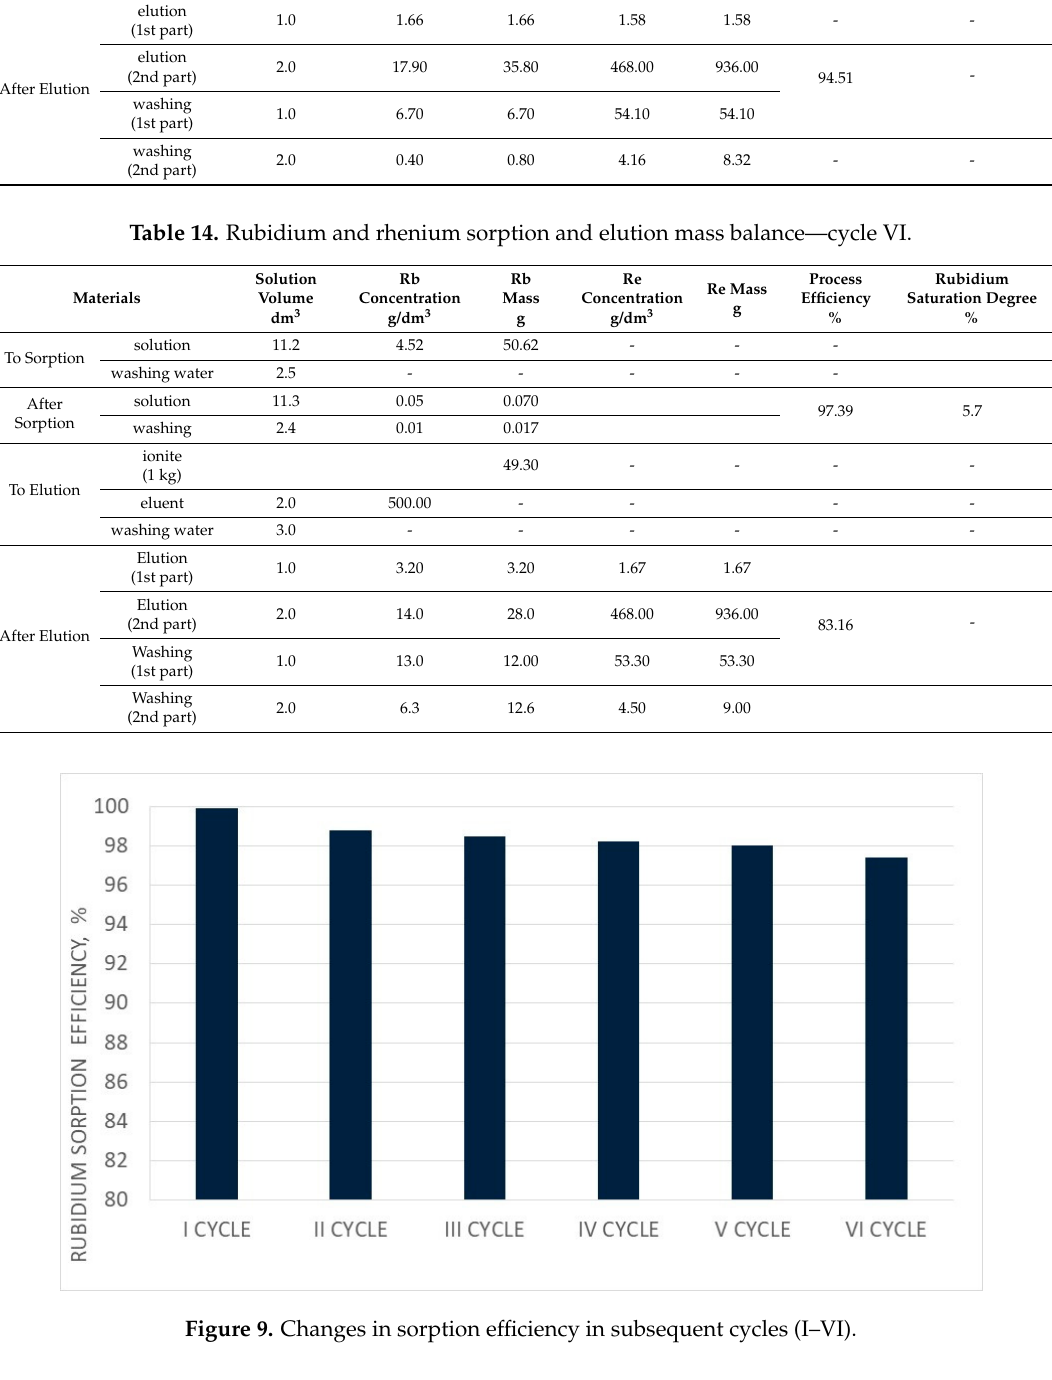
Figure 10. Changes in the elution efficiency in subsequent cycles (I–VI). Figure 11. Changes in the saturation degree of resin by Rb in subsequent cycles (I–VI).